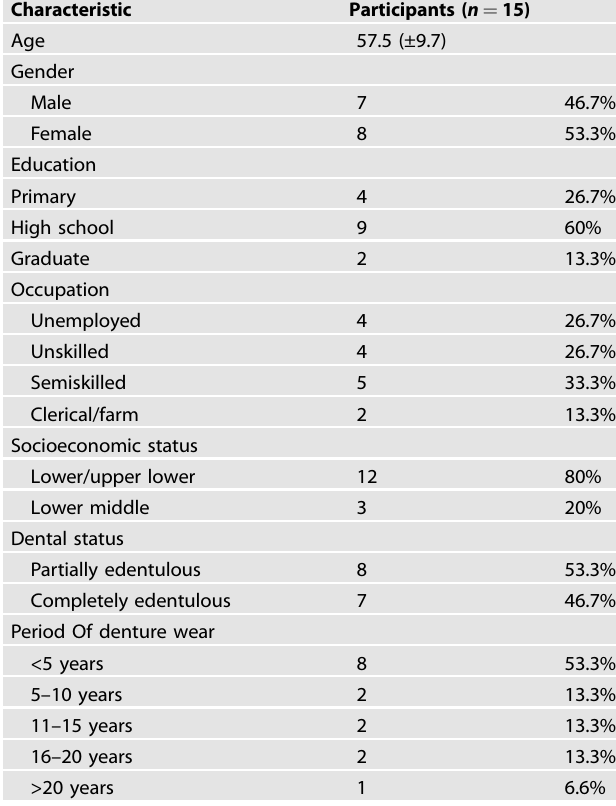
Table 1. Participants ’ sociodemographic